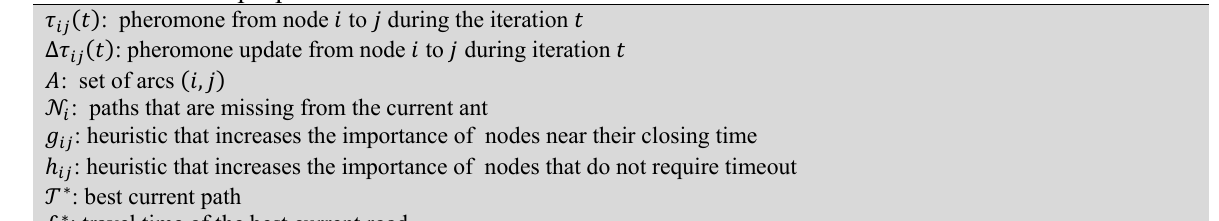
Table 3 Notation used for proposed ACO to solve the